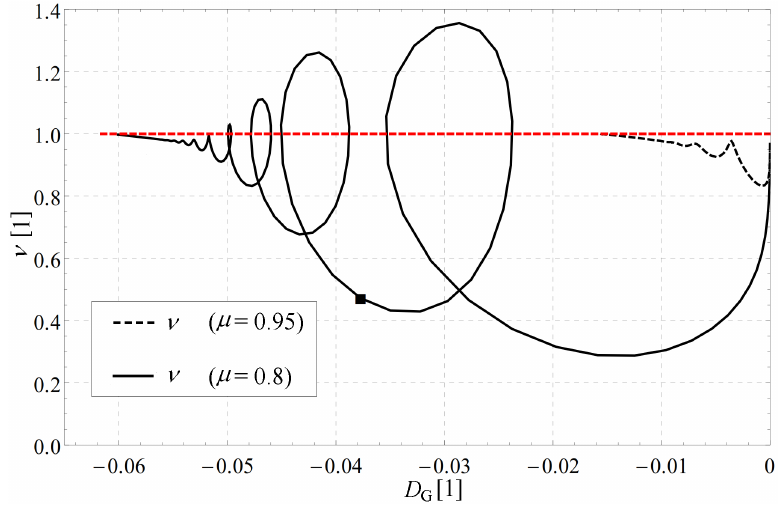
Figure 7. Relevant eigenvalue with different